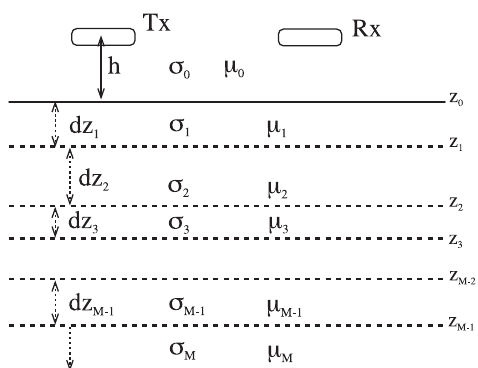
Fig. 3. Stratified subsurface model